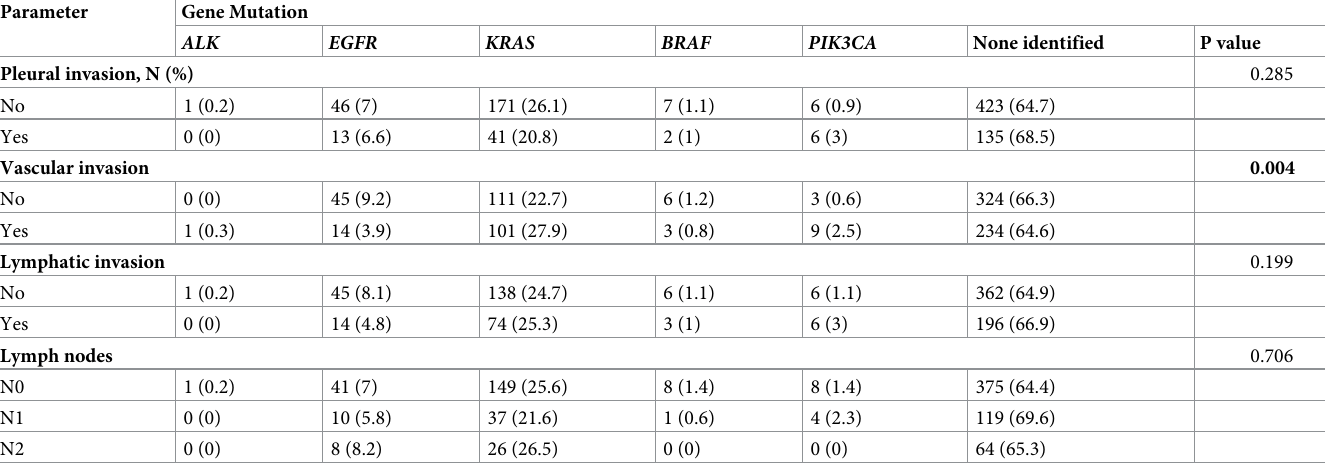
Table 4. Poor prognosis factors of patients with NSCLC (N = 851) and their relationship with the most common gene mutations.